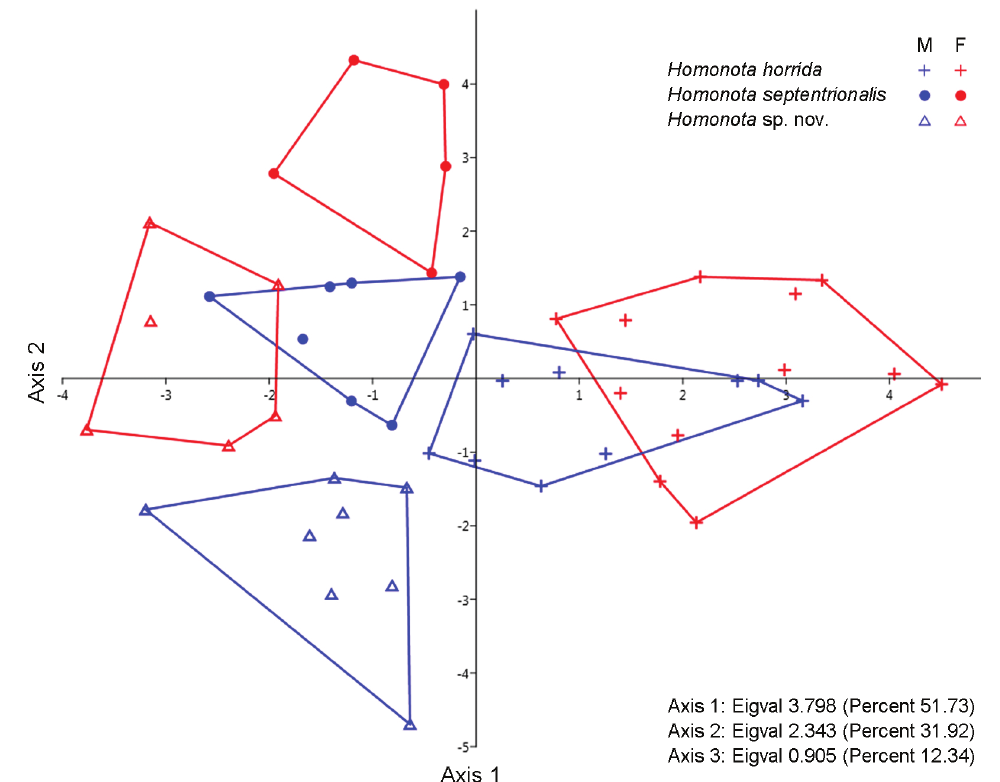
Figure 2. Discriminant Function Analysis scatter plot of individual scores for the three most informative axes for continuous vari- ables of Homonota horrida , H. septentrionalis , and Homonota sp. n. Eigval: Eigenvalues. M: males. F: females.